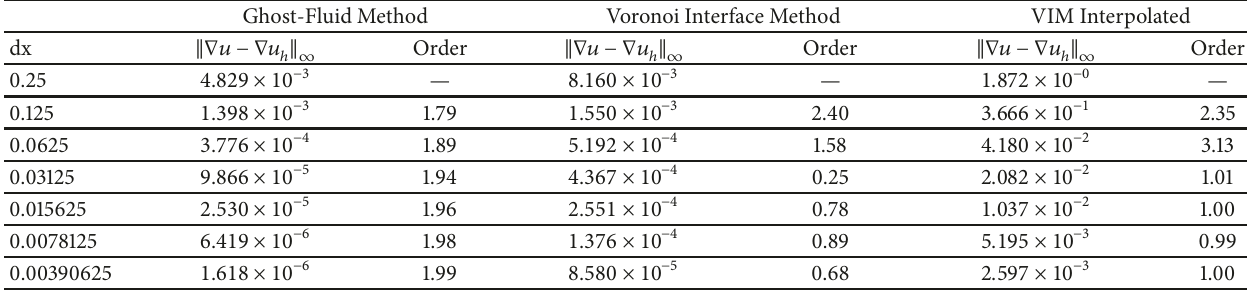
Table 3: Comparison of the 𝐿 ∞ error in the gradient of the solution for the Ghost-Fluid Method and the Voronoi Interface Method, for example, shown in Section 3.1.